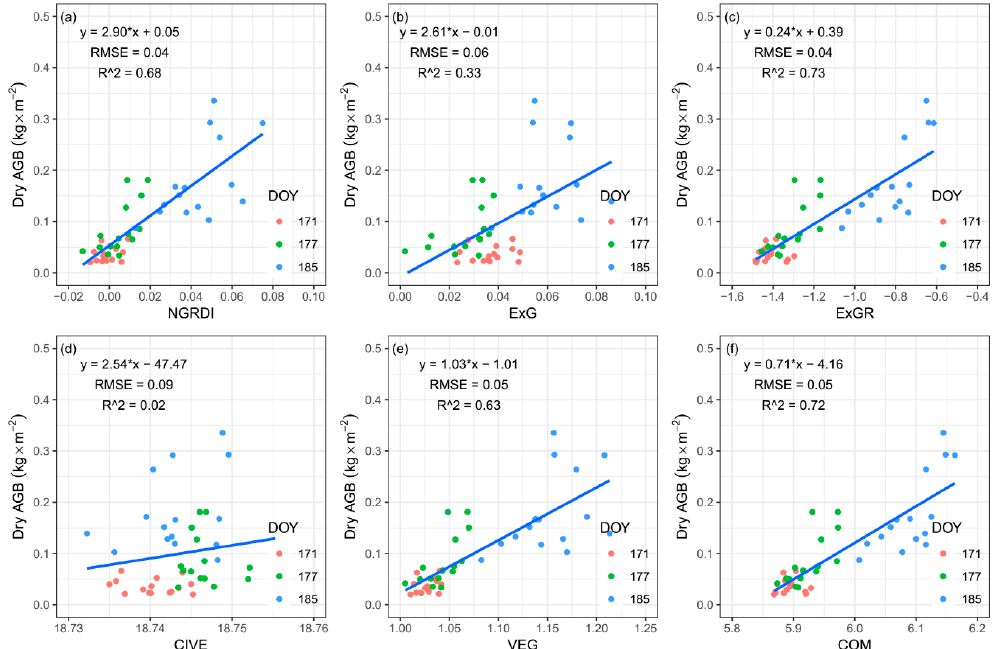
color index of vegetation (CIVE); ( e ) vegetation index (VEG); and ( f ) the combination of ExG, ExGR, CIVE and VEG (COM). R 2 represents the coefficient of determination and RMSE represents the root mean square error.